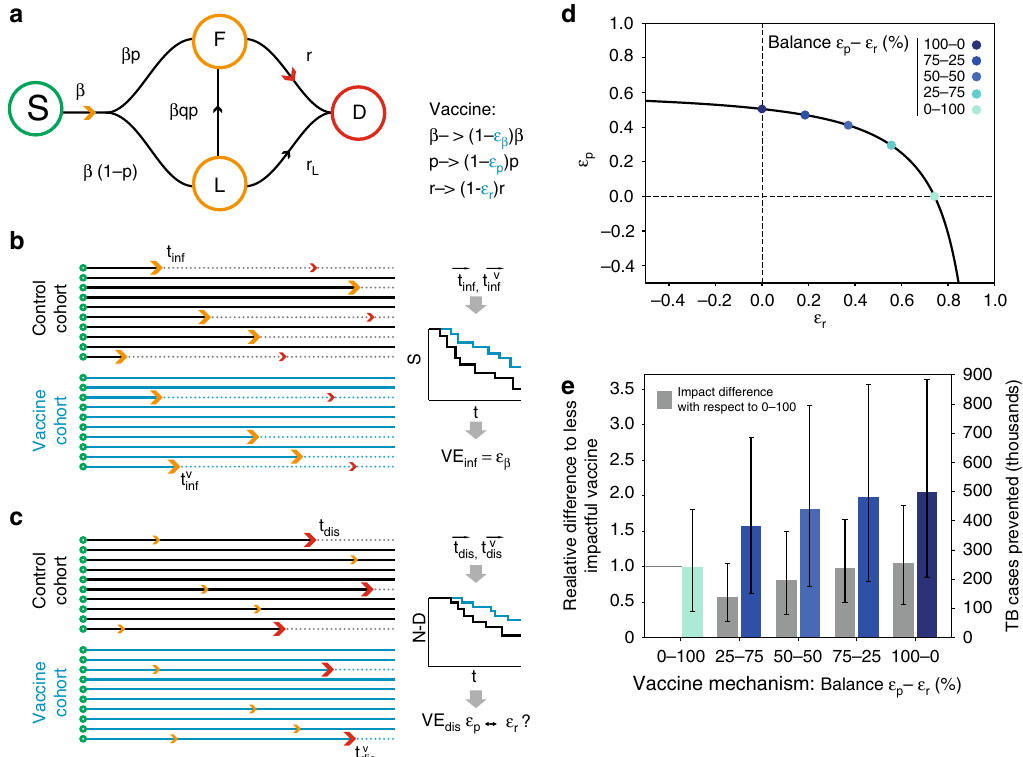
Fig. 1 Equal prevention readouts from vaccine ef fi cacy trials can map to multiple vaccine mechanisms and expected vaccine impacts. a Elementary M.tb . transmission model. S = susceptible, F = infected, fast progression to disease, L = infected, slow progression to disease (LTBI), D = active TB. The epidemiological parameters (black) can be modi fi ed by the vaccine effects (blue). b From the distributions of transition times between the beginning of the trial (green dots) until end-point infection (orange arrows), survival curves are built for the control and vaccine cohorts, and from their analysis, VE inf is estimated. c Equivalent schematics for the estimation of VE dis from survival analysis of transition times from trial ’ s beginning (green) to the end point associated with active TB (red arrows). d Curve of values of ( ε , ε ) compatible with a measurement of POD of VE dis ¼ 0 : 5 after 4 years of follow-up p r (assuming no POI, i.e. ε β ¼ 0). We have marked fi ve different points in this curve, with different balances between ε and ε , to be used in the next p r example. e Foreseen impacts obtained after introducing the vaccines highlighted in d in Ethiopia, at the end of 2025. Blue bars: vaccine impacts. Grey bars: difference in impact estimated between each vaccine and the least impactful case of a vaccine acting enterily through ε (lightest blue). Impacts are r estimated by using a large-scale transmission model 16 as the number of TB cases prevented in the country by the vaccine during the period 2026 – 2050. Error bars (black bars) represent the 95% con fi dence